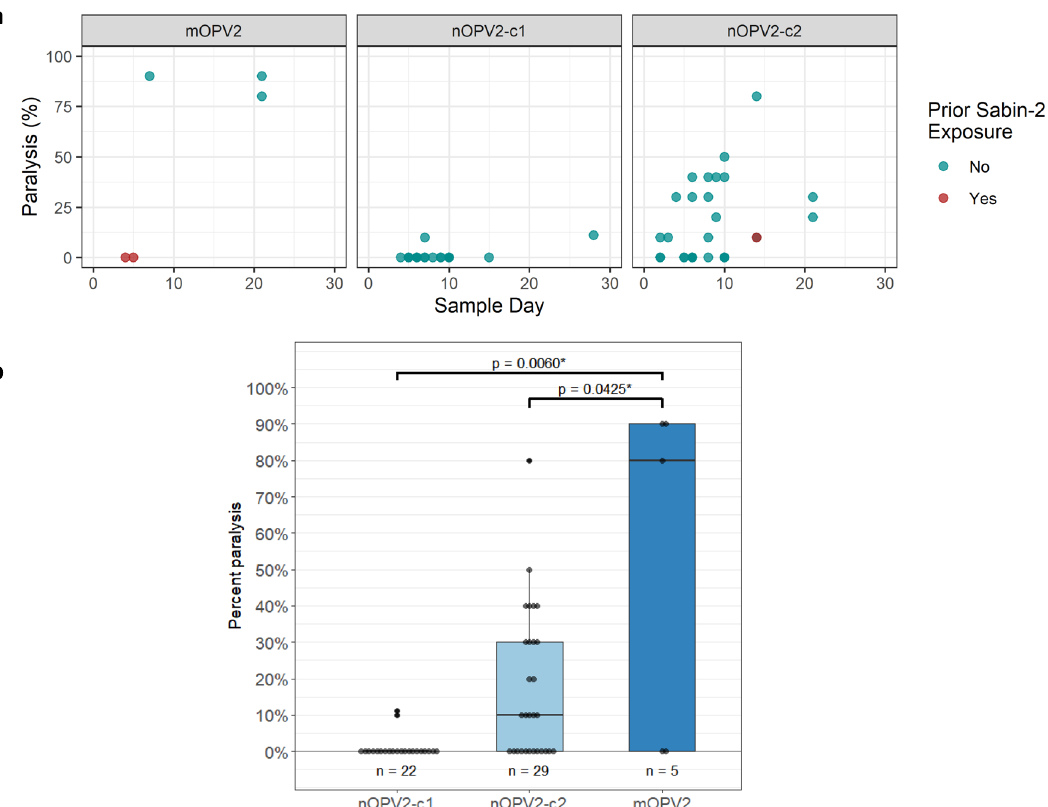
Fig. 1 Neurovirulence summary. a Measured paralysis rate in modi fi ed mouse neurovirulence test. Datapoints are percent paralysis per EES. Paralysis rates for shed virus samples are indicated versus day of EES per vaccine. EES from participants with and without prior Sabin-2 exposure (via routine immunization) are shown by red or green circles. b Comparative analysis of neurovirulence. Datapoints are percent paralysis per EES following intraspinal administration of 10 4 CCID 50 virus inoculum per mouse in the mTgmNVT. The p values indicated are based on estimated odds ratio of paralysis for shed virus of each nOPV2 candidate compared to Sabin-2. Displayed are the median (horizontal line), fi rst and third quartiles (lower and upper box boundaries, respectively), with whiskers extending to the largest (smallest) value within 1.5 times the inter-quartile range of the upper (lower) box